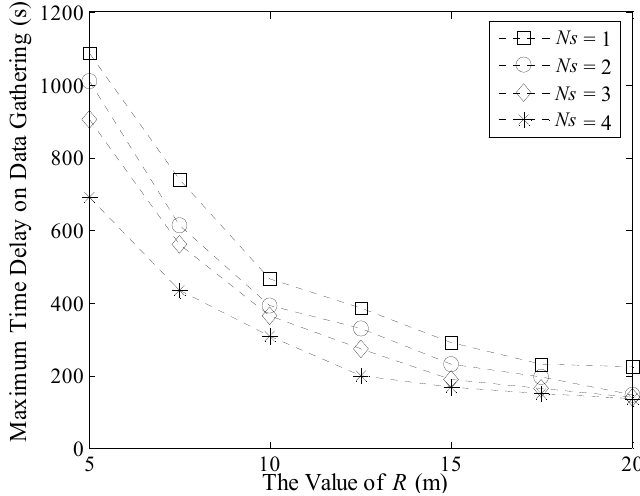
Figure 22. Maximum time delay on data gathering (200 m × 200 m, 500 nodes).